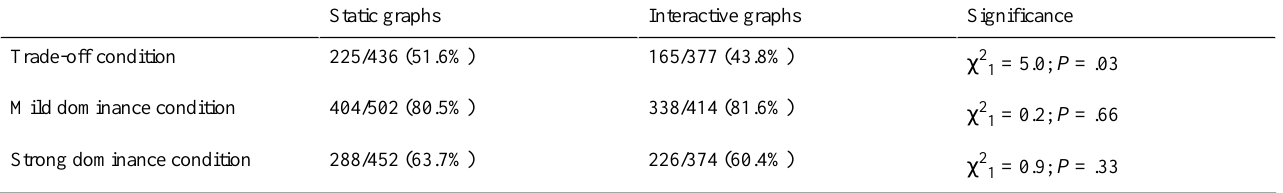
Table 4. Percentage of participants correctly identifying which treatment had a higher rate of mouth and throat problems, by condition and graphic